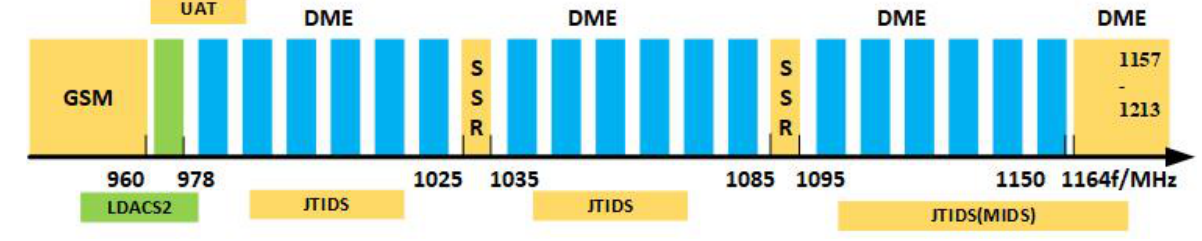
Figure 1. L-band Spectrum Occupancy